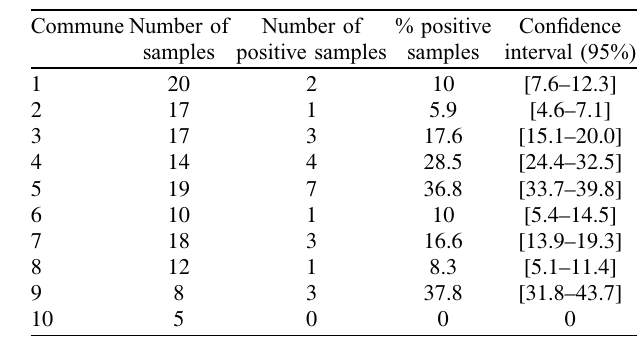
Table 1. Distribution of the samples collected in Armenia, Quindío, Colombia during 2014 – 2015 by commune and positive samples from domestic cat feces using B1 PCR to detect T. gondii